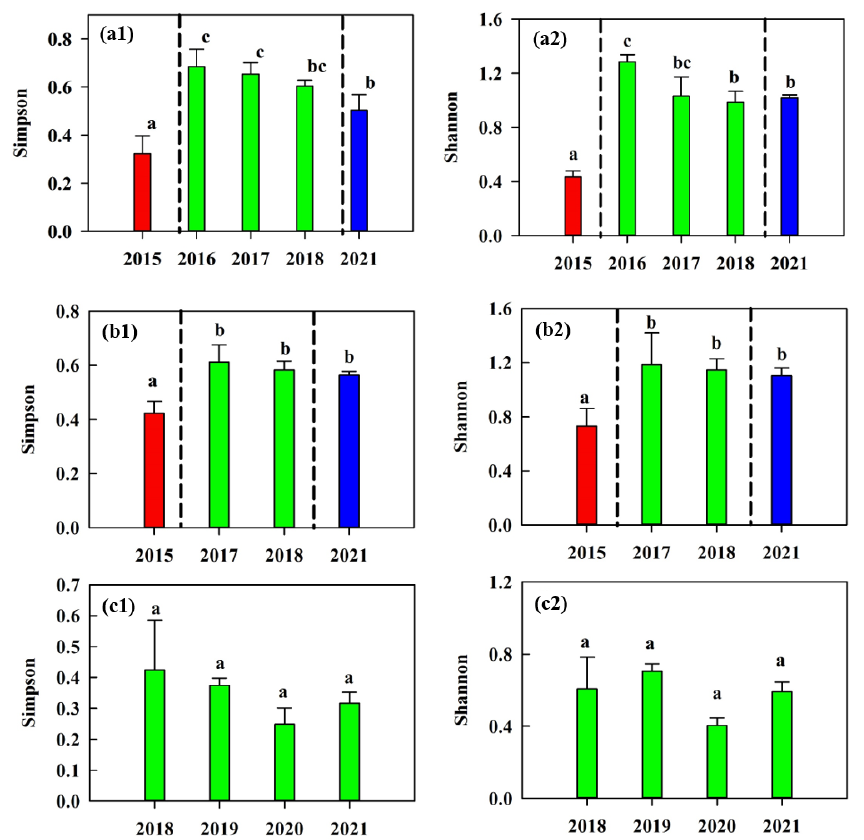
Figure 10. Temporal and spatial variation characteristics of species diversity in the mainstream area of the Tarim River. ( a1 , a2 ) are the upper reaches of the mainstream area of the Tarim River, ( b1 , b2 ) are the middle reaches of the mainstream area of the Tarim River, and ( c1 , c2 ) are the lower reaches of the mainstream area of the Tarim River.